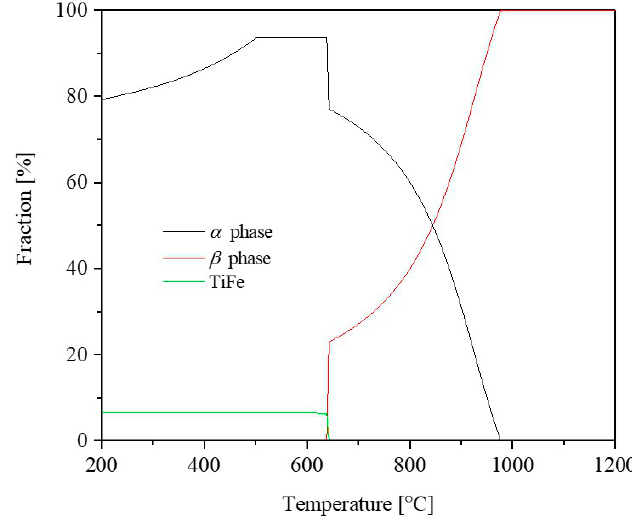
Figure 1. Equilibrium phase information of Ti-5Al-3.5Fe alloy used in this work as a function of temperature, showing possible phases and their fraction; this result was obtained by JMatPro-v8 calculation with Ti database.